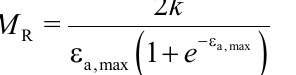
Fig. 3. Main types of rock samples. a-b: megacryst-bearing, medium-grained, biotite- monzogranites, c:medium-grained, biotite-monzogranites with elongated monzonitic enclaves, d: